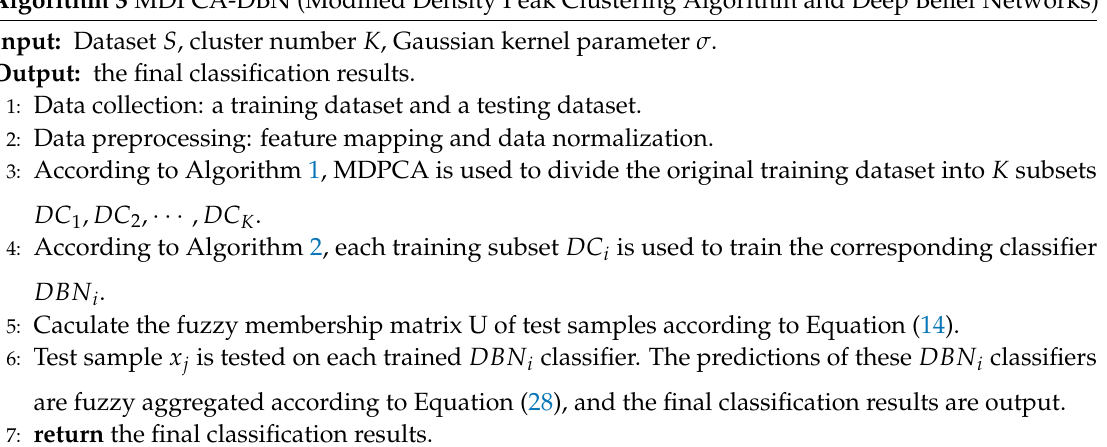
Algorithm 3 MDPCA-DBN (Modified Density Peak Clustering Algorithm and Deep Belief